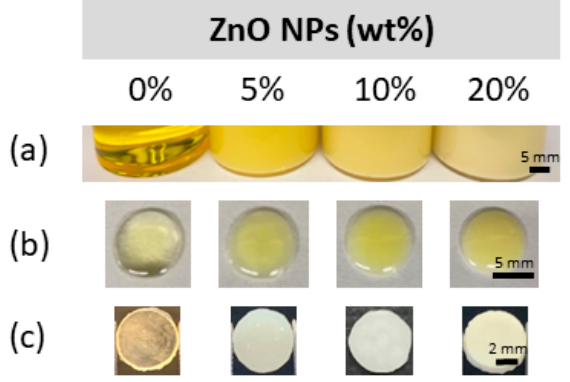
Figure 1. The degree of conversion (DC) for the methacrylate-based resin blends. * Indicates a statistically significant decrease from the control resin blend (0 wt% ZnO NPs) (* p < 0.05; n = 3).